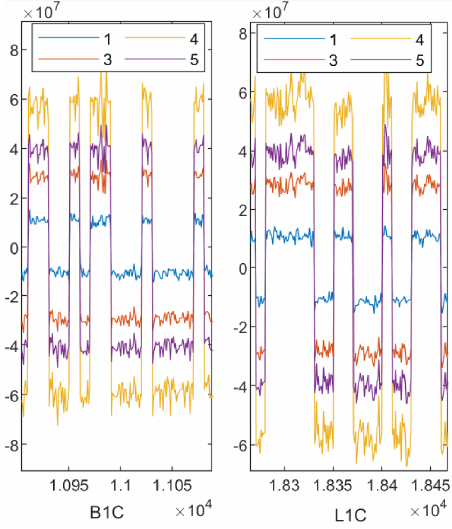
Figure 12. The amplitude of the signal data stream.